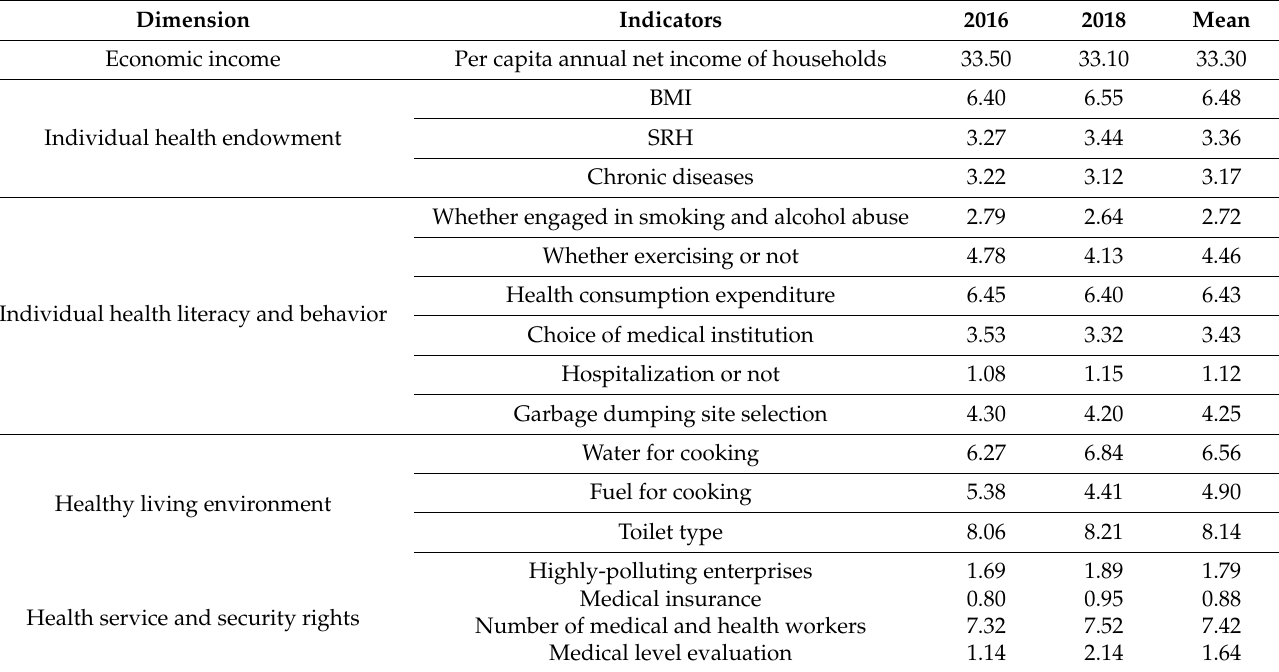
Table 7. Decomposition of the contribution rate of each indicator at K = 0.3